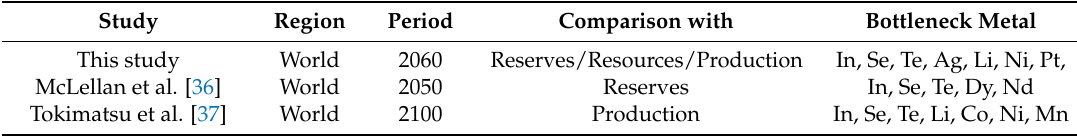
Table 9. Comparison of this study to previous studies which evaluated bottleneck